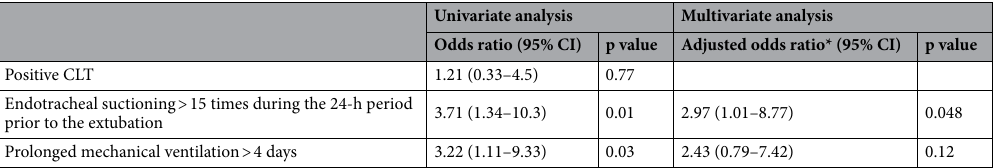
Table 6. Univariate and multivariate logistic regression analyses for PES. PES post-extubation stridor, CI confidence interval, CLT cuff leak test. *Adjusted by gender, BMI > 25 kg/m 2 , and positive CLT.